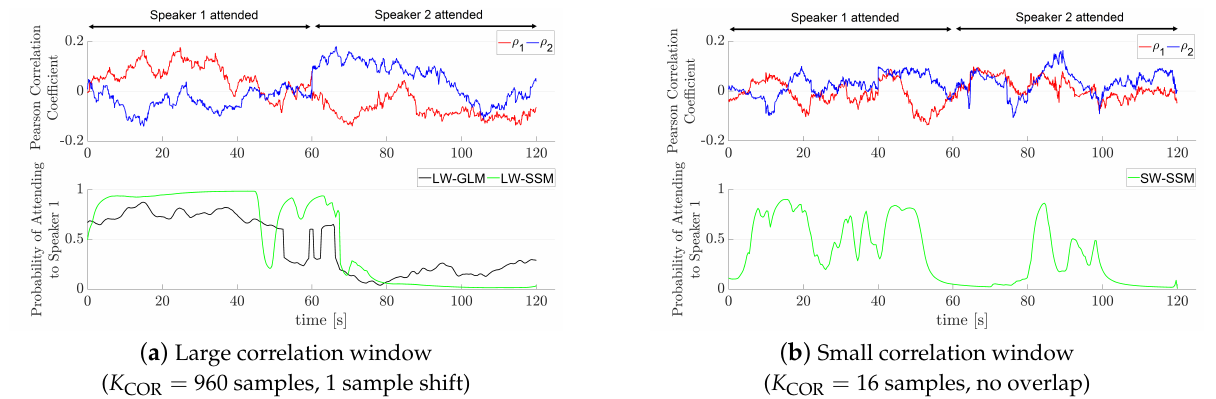
Figure 5. Exemplary correlation coefficients of speaker 1 and speaker 2 and probability of attending to speaker 1 from the open-loop AAD phase when using AAD algorithms employing ( a ) a large correlation window (LW–GLM, LW–SSM) and ( b ) a small correlation window